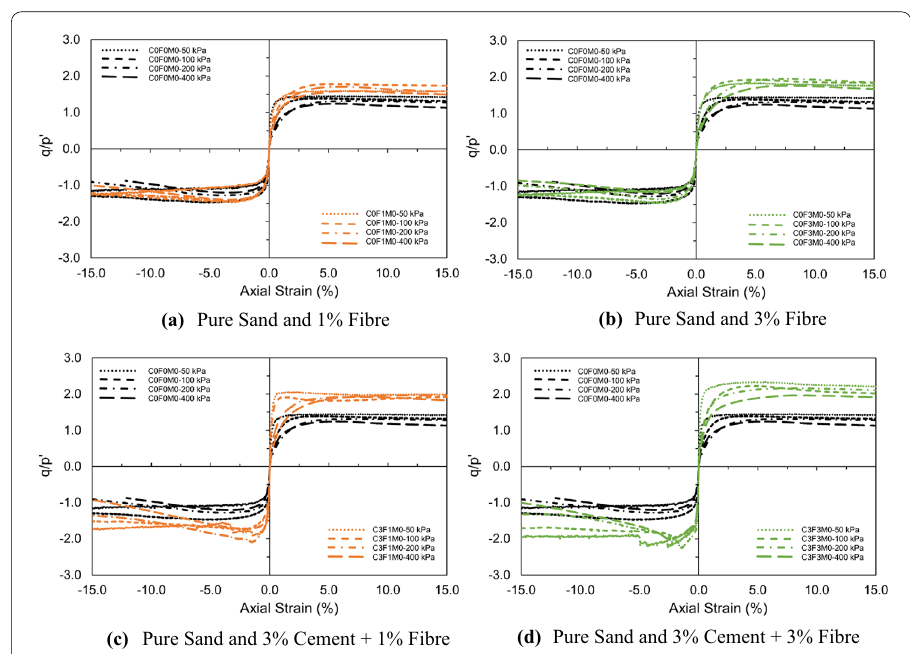
Fig. 4 Stress ratio ( q / p ′ ) versus axial strain ( ǫ a ) curves from CID tests for unreinforced, fibre, and fibre reinforced cemented Toyoura sand specimens consolidated to varying mean effective stresses ( p’ ) a Pure sand and 1% fibre b Pure sand and 3% fibre c Pure sand and 3% cement